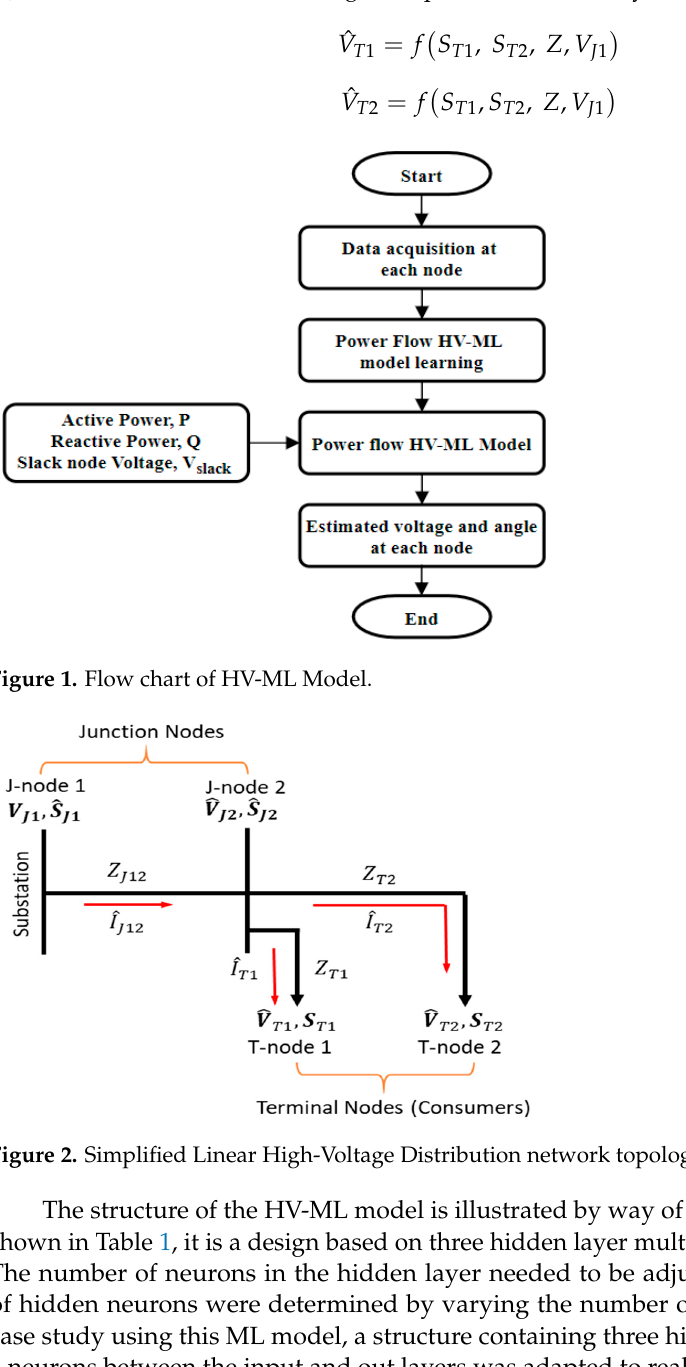
Figure 2. Simplified Linear High-Voltage Distribution network topology .